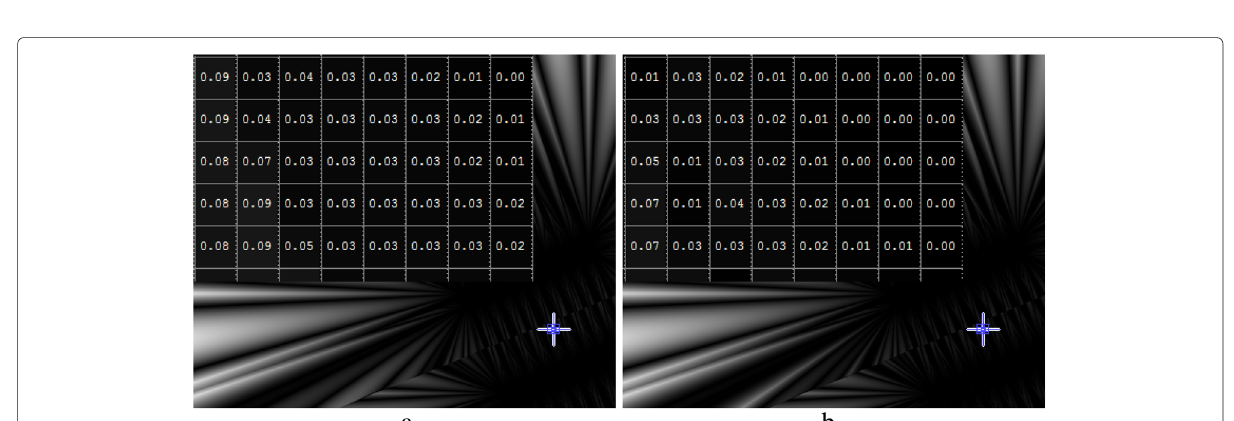
Fig. 12 Error maps of portion of SOP3 generated by a 7 × 7 chamfer mask. Mean absolute error (MAE) and mean squared error (MSE) are computed from the selected portion of the map. The reference error map has all entries zeros (100% black). a Butt et al. (total error = 0.0383). b Proposed (total error =